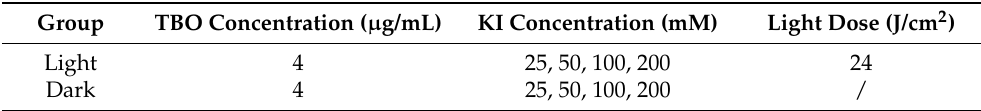
Table 1. Parameters for varying potassium iodide (KI) concentration on toluidine blue O (TBO)- mediated antimicrobial photodynamic therapy (aPDT) plus KI.